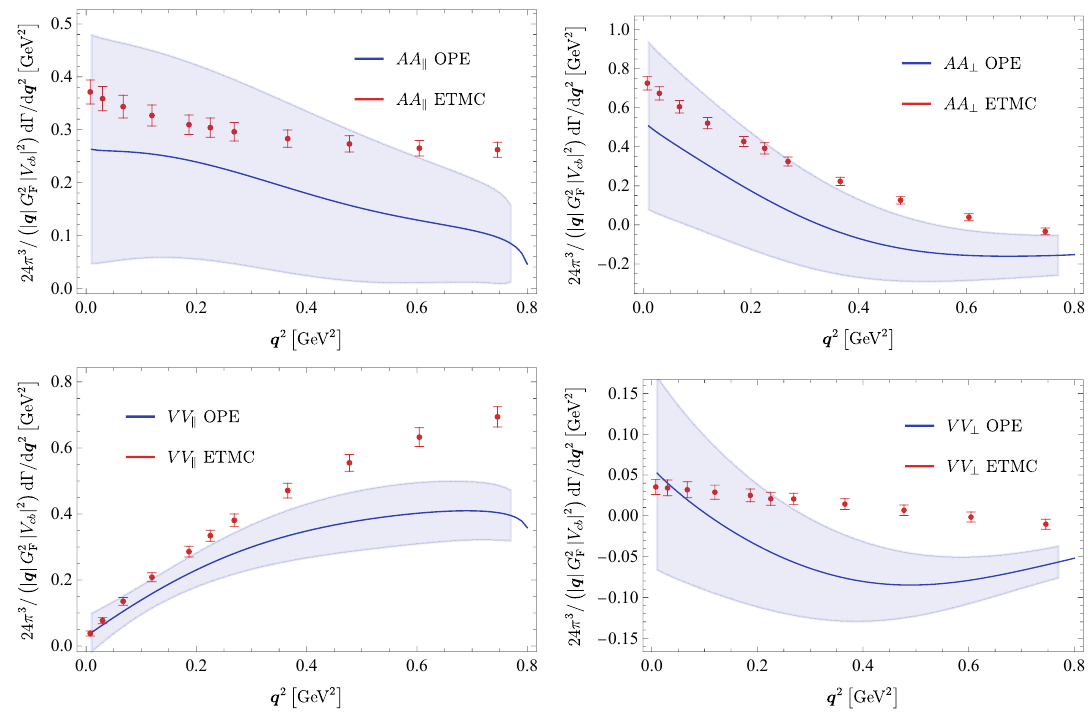
Figure 24 . Differential q 2 spectrum computed with a sigmoid approximation to the kernel with σ = 0 . 12 m B . The plots show the comparison between OPE and ETMC